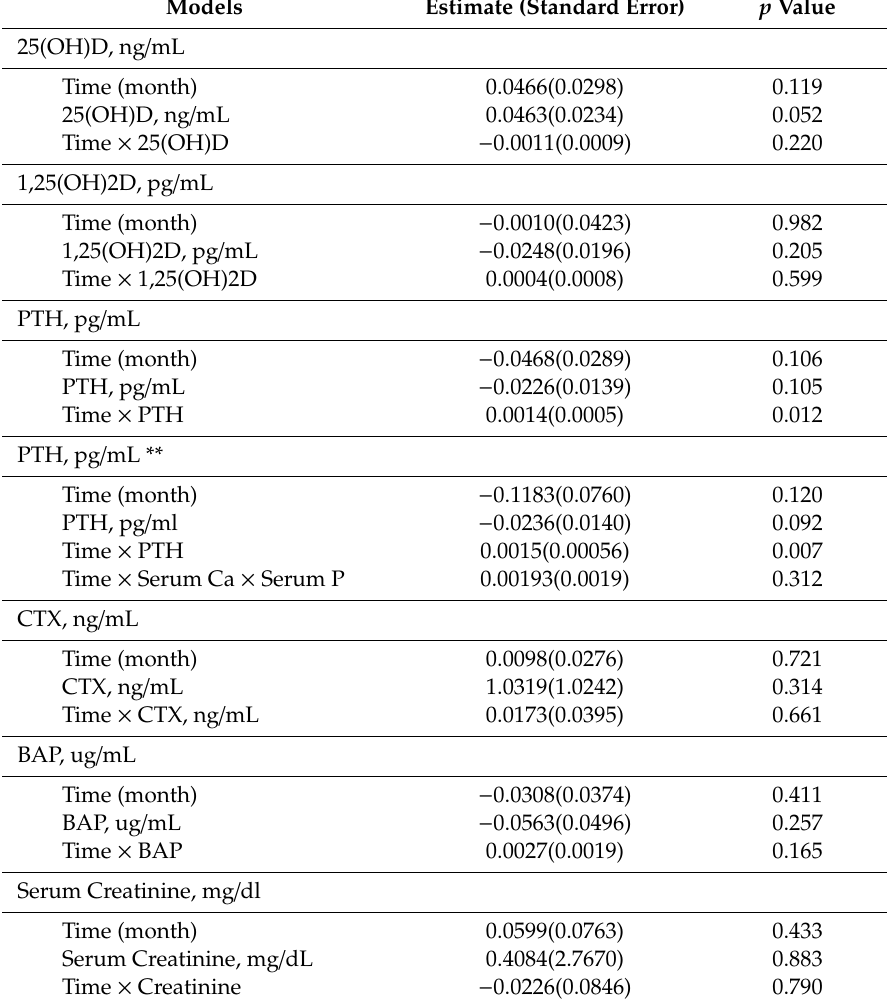
Table 2. Mixed e ff ects logistic regression models for AAC (score ≥ 5) using vitamin D metabolites and other biomarkers.